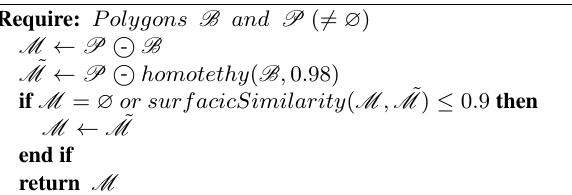
Algorithm 1 Compute building-into-parcel inner-fit